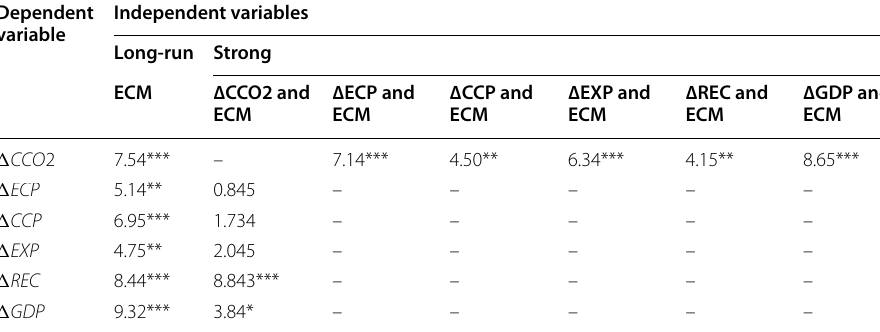
Table 7 Long-run and strong